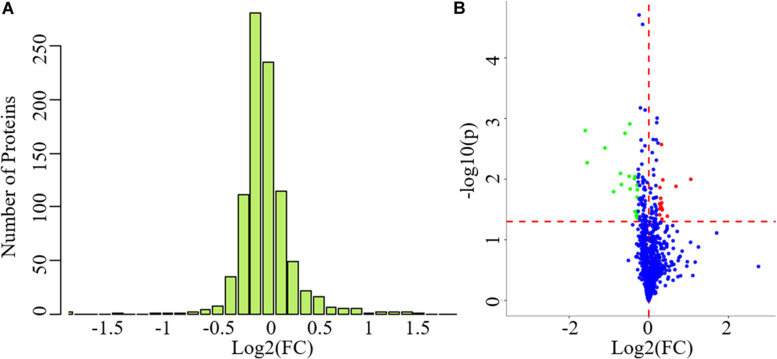
The exhibition of whole proteins detected in plasma and the differentially expressed proteins between PD patients and healthy controls. (A) Protein ratio distribution, (B) volcano plot showed FC values and p-values of all the identified proteins. Red dots represent increased differentially expressed proteins while green dots represent decreased proteins. FC value was calculated as the ratio of the average mass response area between the two groups (FC value = PD/HC). p-Value was calculated using Mann-Whitney U-test. PD, Parkinson’s disease; HC, healthy control; FC, fold change. Blue dots represent unchanged proteins. The horizonal red dashed lines indicate a p-value < 0.05 while the vertical red dashed lines indicate FC = 0.